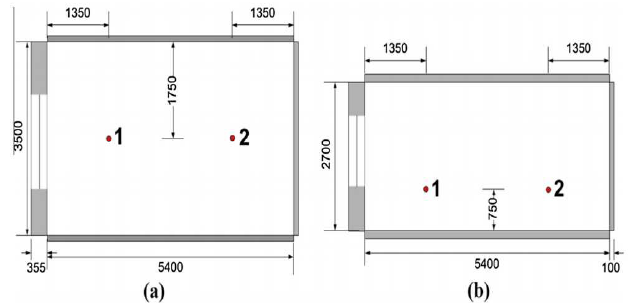
Figure 1. Representation of the office on two dimensions.